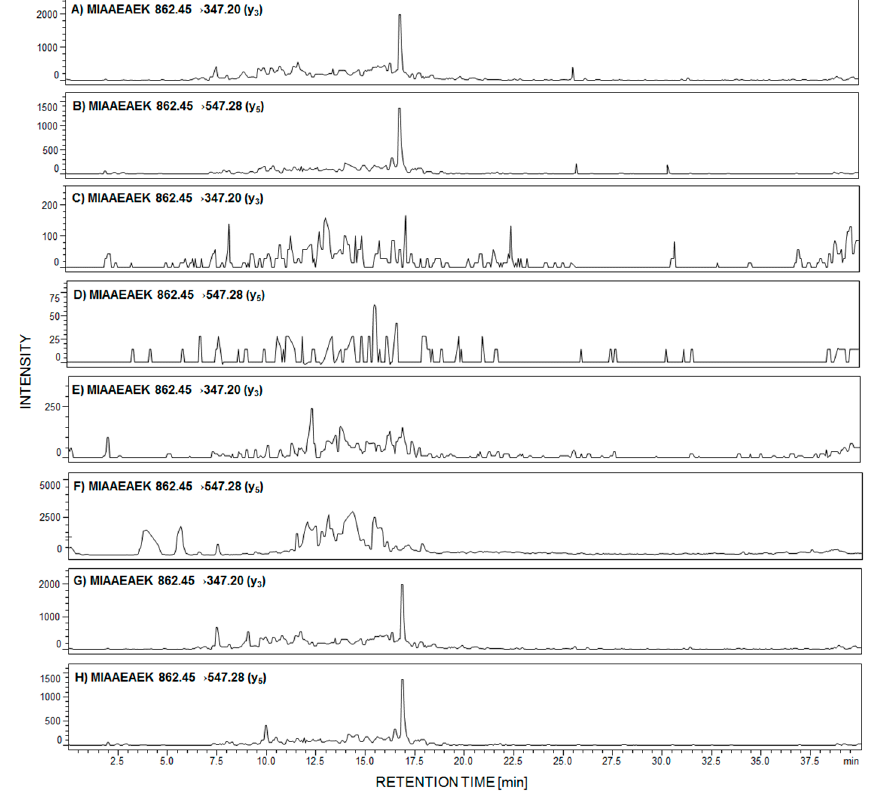
Figure 4. MRM investigation of 292 MIAAEAEK 299 peptide in urine sediment tryptic digest from patient with diagnosed membranous nephropathy (MN) ( A , B ); focal segmental glomerulosclerosis (FSGS) ( C , D ); membranoproliferative glomerulonephritis (MPGN) ( E , F ); and IgA nephropathy ( G , H ).